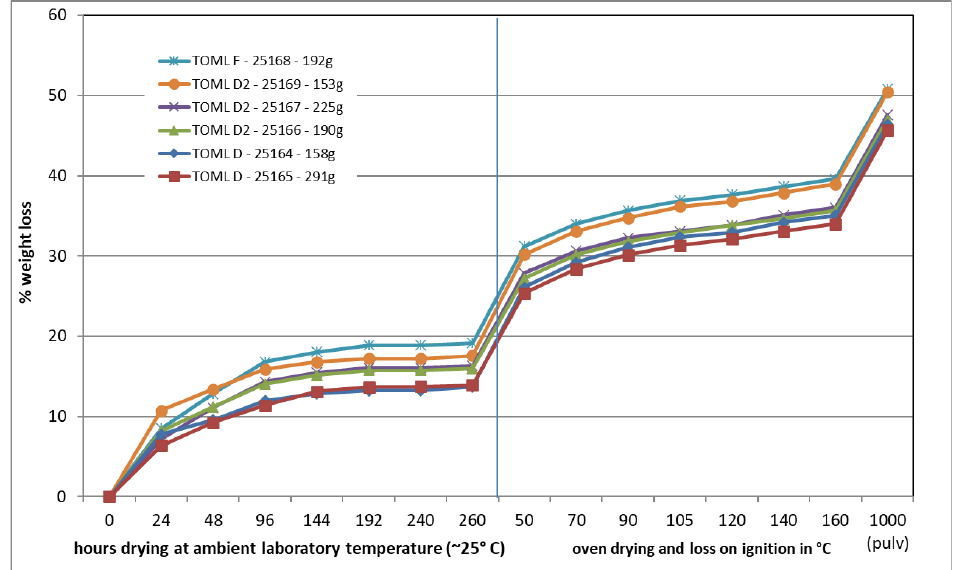
Figure 23. Three-stage drying curve for polymetallic nodule samples. Source: Lipton et al. [12].